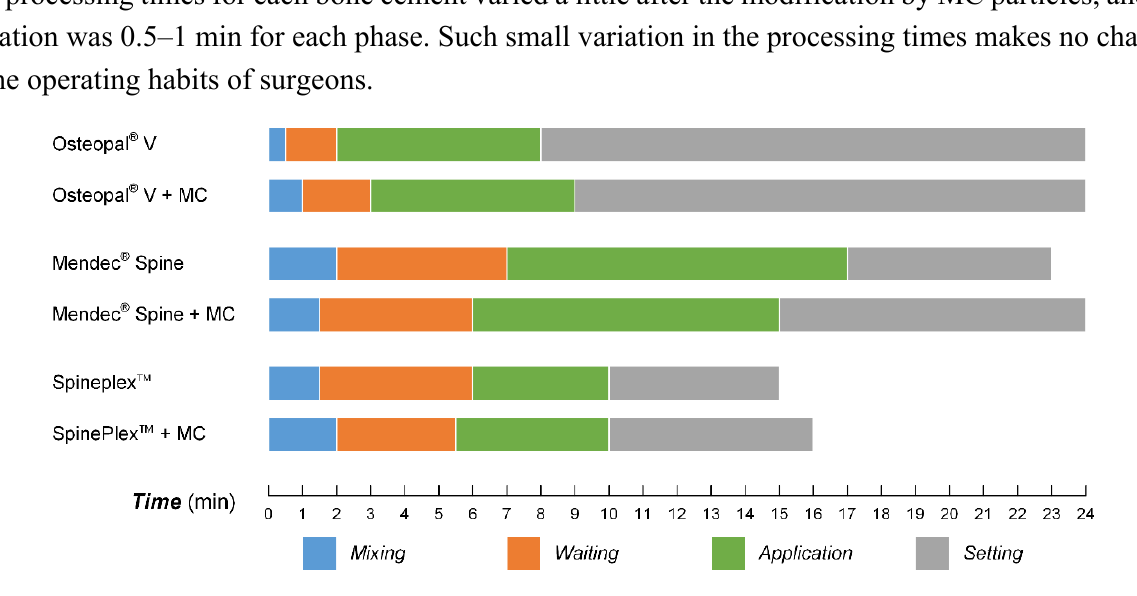
Figure 10. Processing times for the bone cements before and after the modification by MC. Figure 11 takes Osteopal ® V bone cement as an example to show operation process and processing times of the MC modified PMMA bone